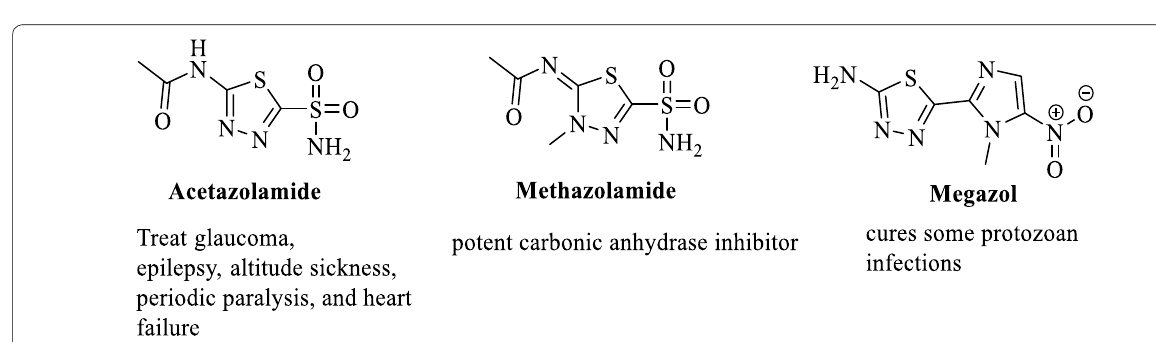
Fig. 2 Examples of drugs containing a 1,3,4‑thiadiazole